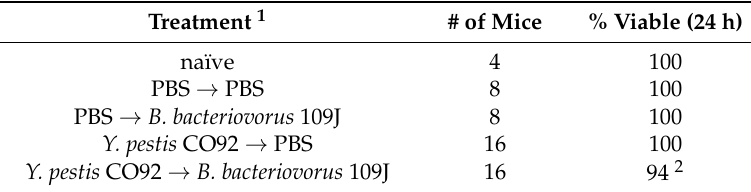
Table 1. Survival of mice 24 hours post-infection with Y. pestis